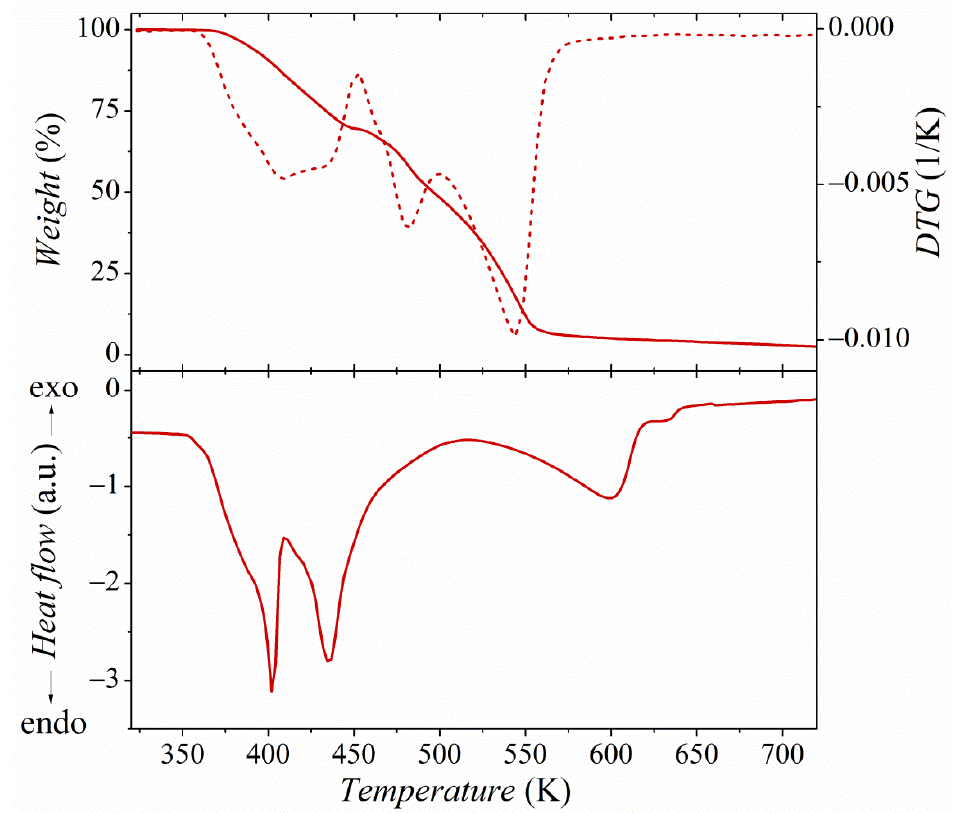
Figure 4. TGA/DTG curves (top panel) and DSC curves (bottom panel) of PyrHem×H 2 O.